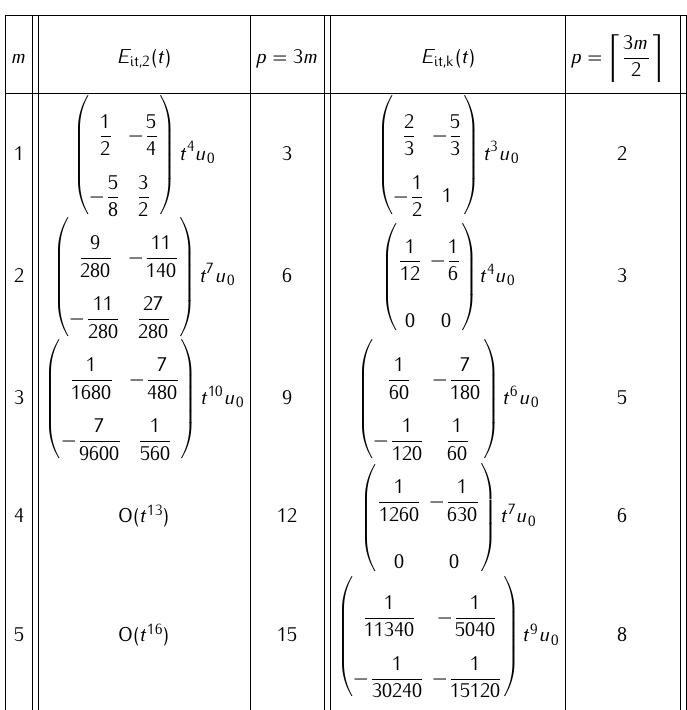
Table 1. The leading term of the error for the two-level and k -level methods, k